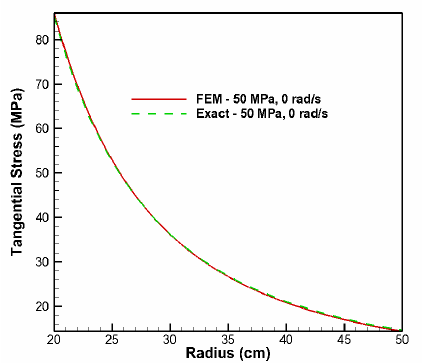
Figure 5. Radial stress under 𝑞